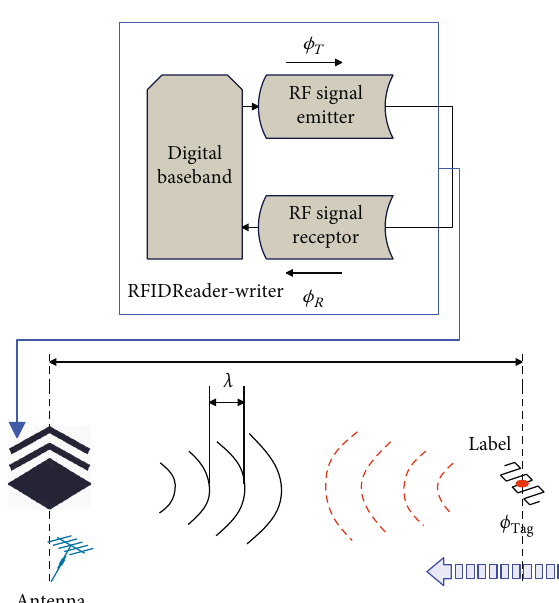
Figure 5: Tag backscatter communication model.